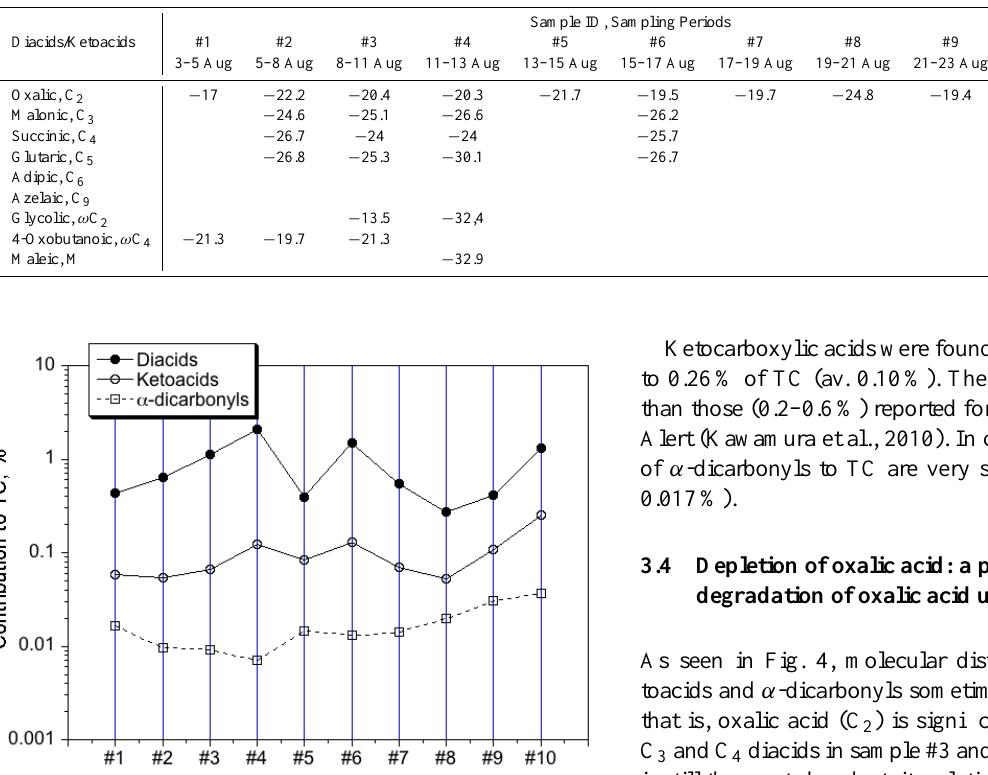
Table 2. Stable carbon isotopic composition (‰) of dicarboxylic acids and ketocarboxylic acids in the marine aerosols from the Arctic Ocean in 2009.